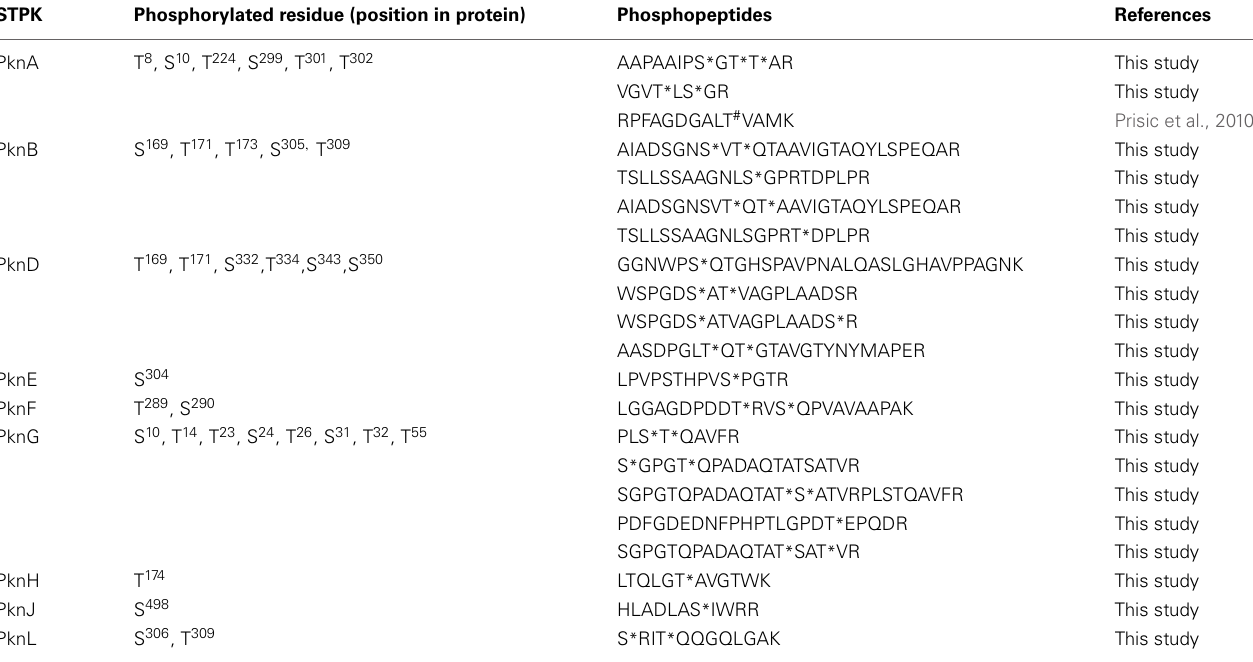
Table 2 | Serine/threonine kinases and their phosphorylation sites identified in this study.